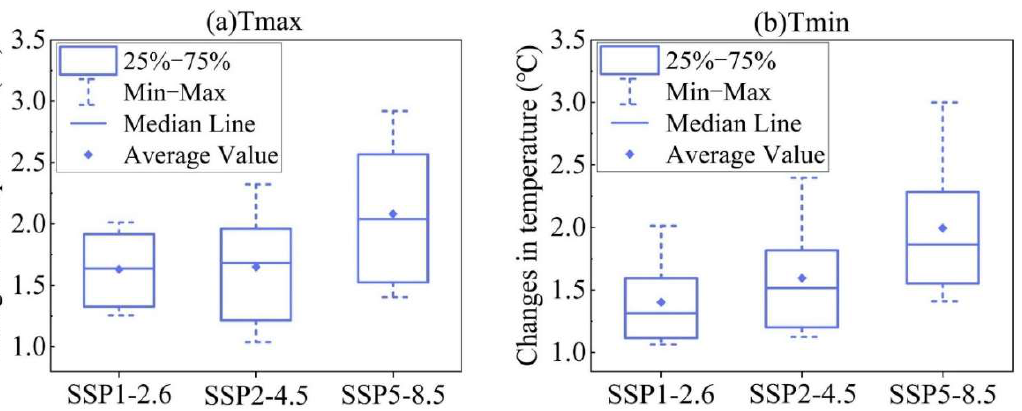
Figure 10. A box − plot of temperature changes of 6 GCMs in ( a ) Tmax, and ( b ) Tmin relative to Figure 10. A box−plot of temperature changes of 6 GCMs in (a) Tmax, and (b) Tmin relative to base- baseline period under SSP1-2.6, SSP2-4.5, and SSP5-8.5 climate line period under SSP1-2.6, SSP2-4.5, and SSP5-8.5 climate scenarios.